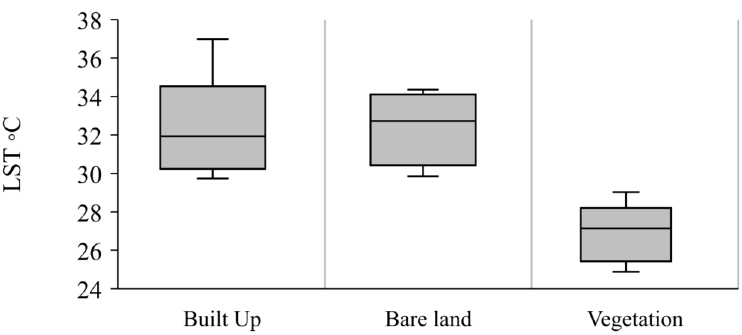
Figure 8. LST characteristics of different land use classes in the study area during 6 time periods from 1987 to 2019. Table 3. ANOVA test results in examining the significance of LST difference between the studied land use classes (1987–2019).